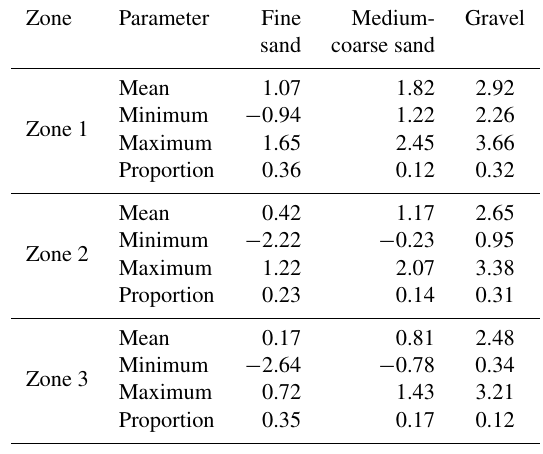
Table 2. Statistical data of logarithm hydraulic